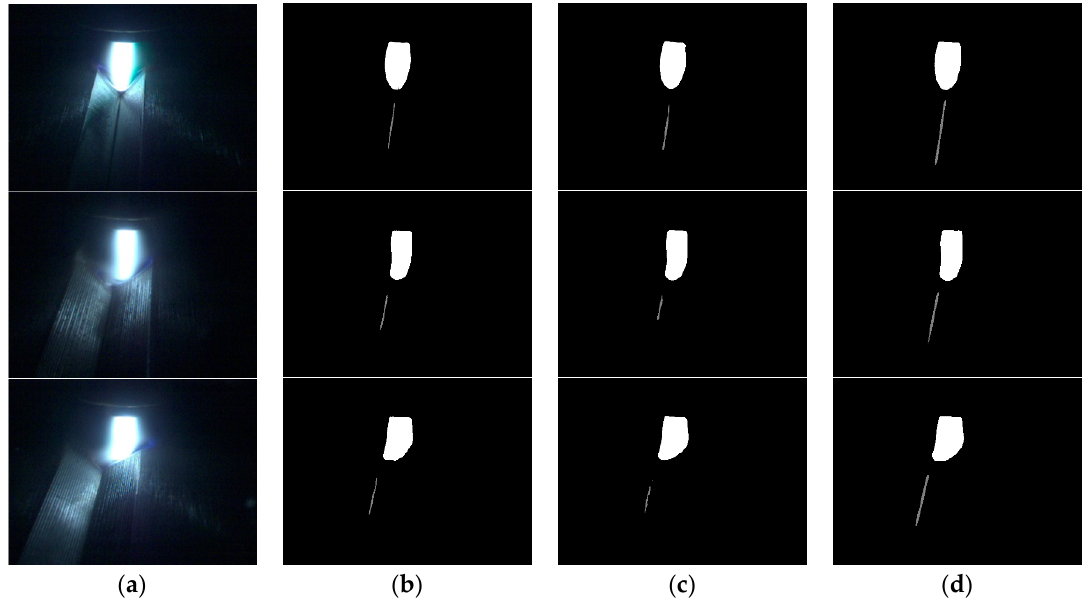
Table 2. Results of the intersection of union.